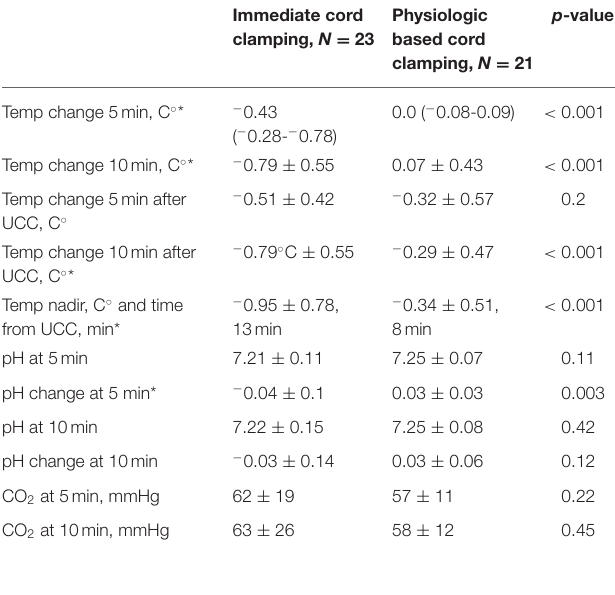
TABLE 2 | Experimental results presented in means and standard deviation or median and interquartile range (25 to 75%), Temp, temperature; min, minutes; C ◦ ,